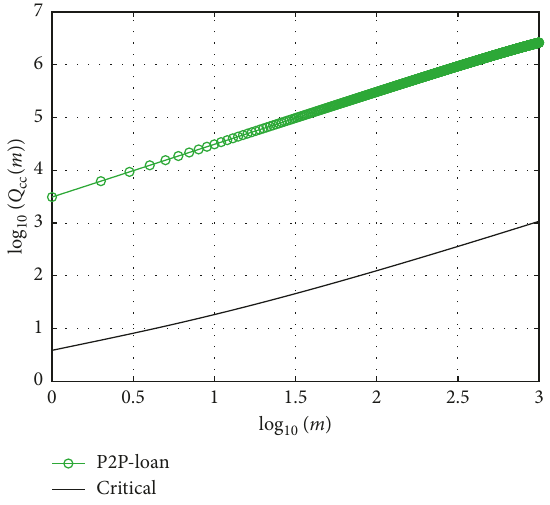
Figure 1: Cross-correlation test ( Q